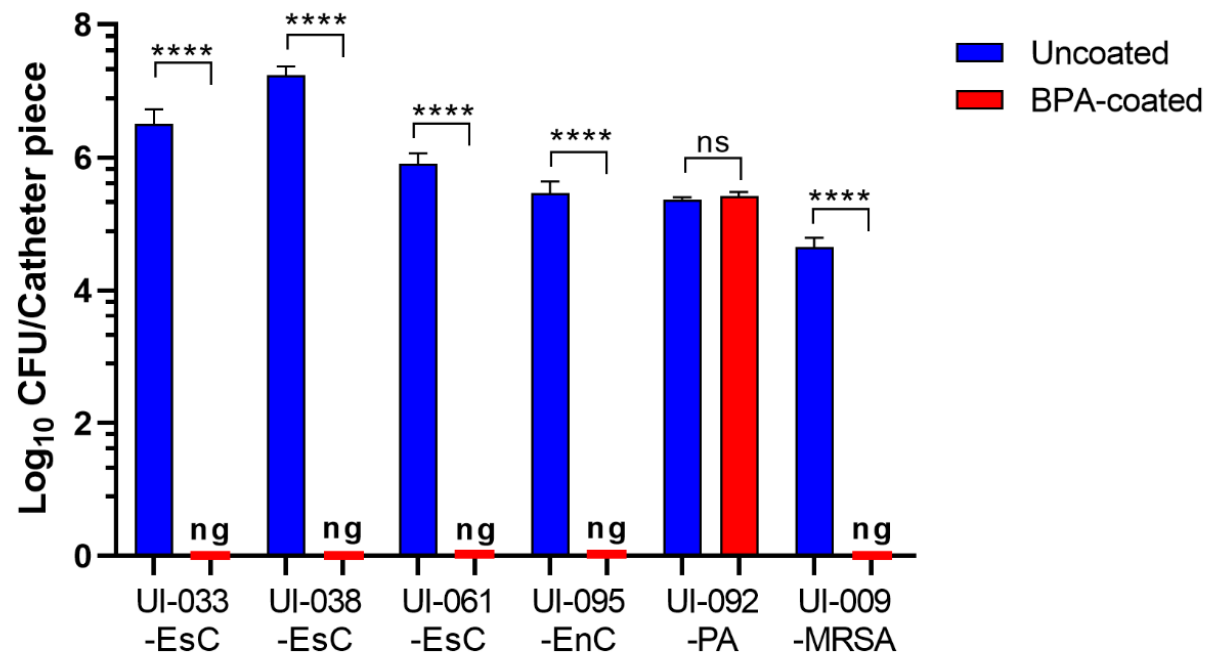
Figure 4. BPA-coating on silicone catheters inhibits biofilm formation by most of the uropathogens. The BPA coating was not effective in preventing biofilm formation by UI-092-PA. Values represent the average of three independent experiments ± SEM; ns, no significance; ****, p < 0.0001.